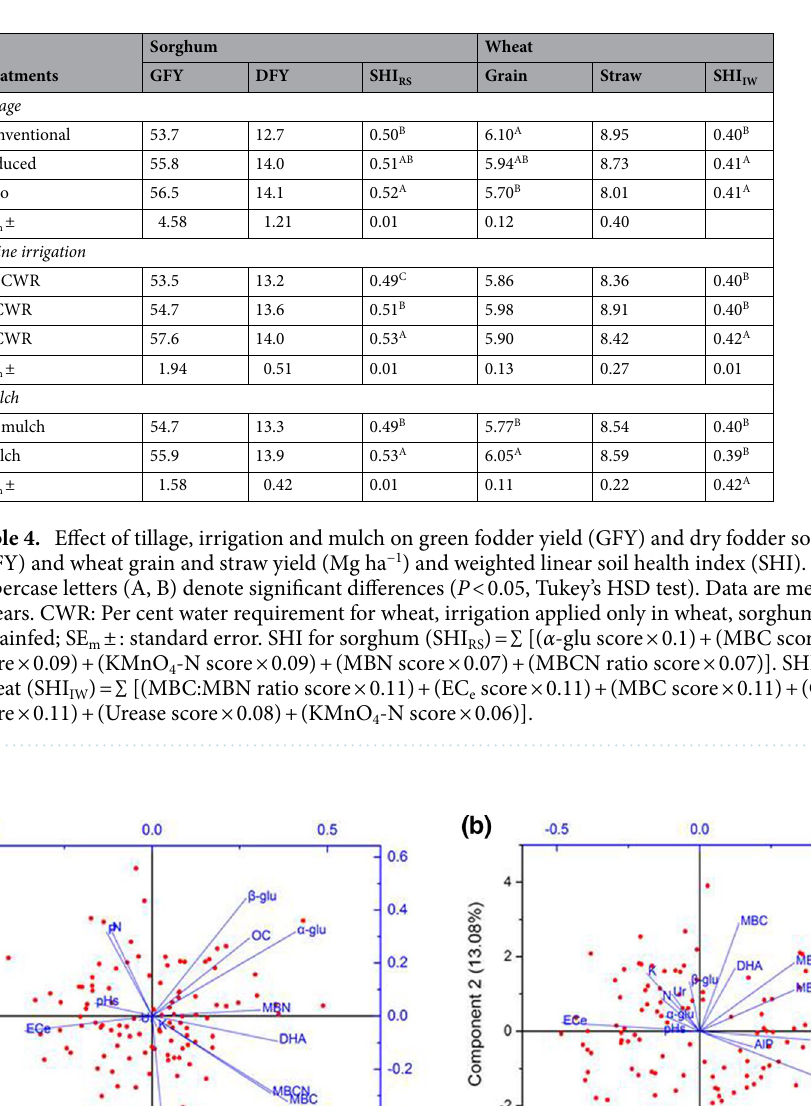
ghum, the weighted factors 0.10 for both α -glu and MBC from PC1, 0.09 for both KMnO 4 -N and EC e from PC2, 0.07 for MBN and MBC:MBN ratio from PC3 and PC4, respectively, were used (Table 2). The weighted mini-